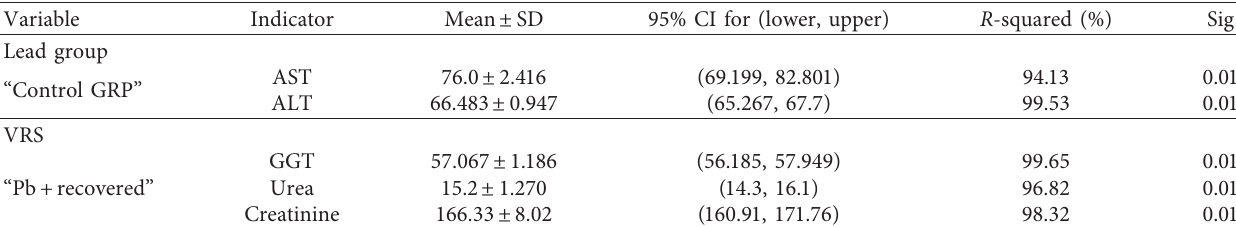
Table 1: Distribution on the effect of lead-induced heavy metal toxicity in rats.